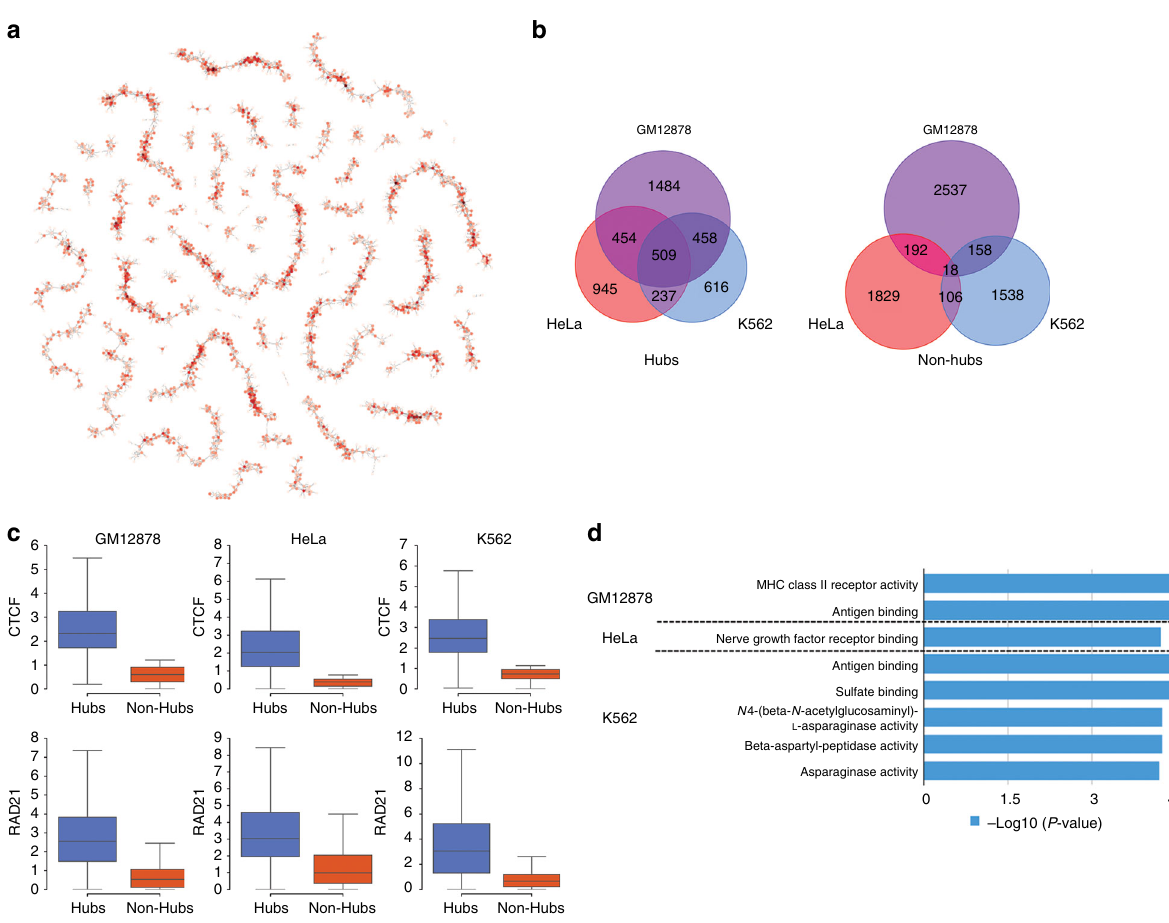
Fig. 7 Topological properties of the CTCF-mediated interaction network and their association with biological functions. a Visualization of the CTCF- mediated interaction network of chromosome 1 in GM12878 cells. Each node represents an anchor, with color representing the degrees of connection. Each edge represents an interaction. b Overlap of predicted hubs and non-hubs among each cell type. Hubs are more conserved than non-hubs. c Distribution of the binding af fi nity of architectural proteins, CTCF (top) and RAD21 (bottom), on predicted hubs and non-hubs. P -values <1e-300 for all cases, Mann – Whitney U -test. d Functional enrichment analysis of hubs using GREAT. The x- axis represents the binomial P